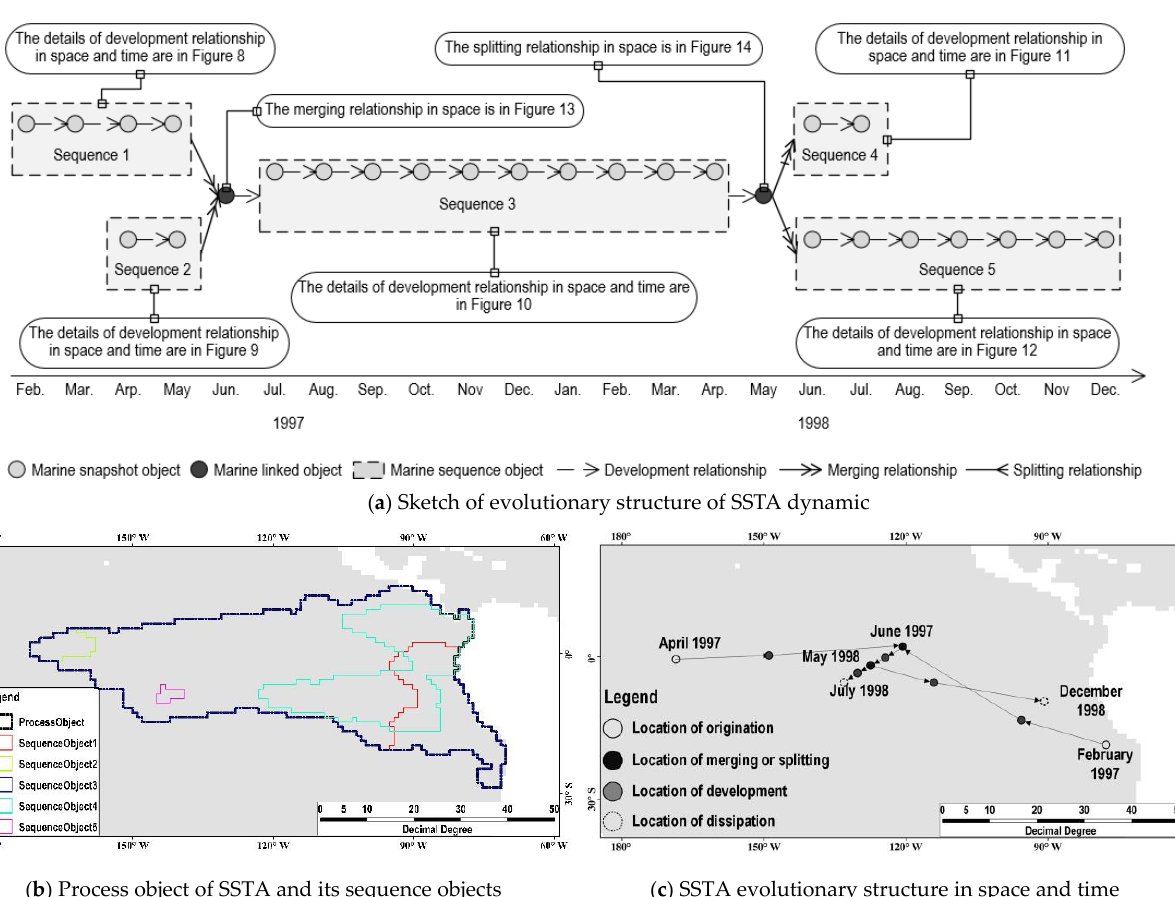
Figure 15. Process object of SST and its evolutionary structure in space and time.